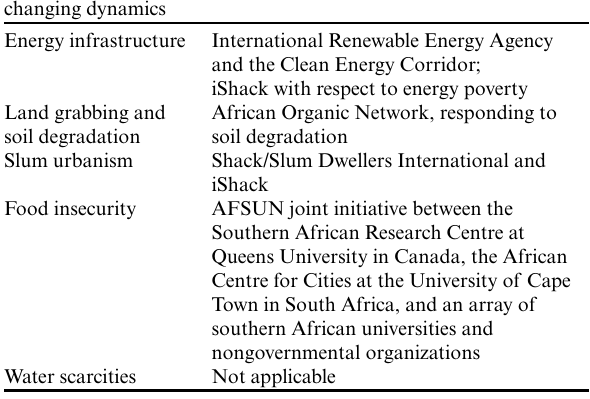
Table 1. Less-recognized game-changing dynamics and associated social and system innovation